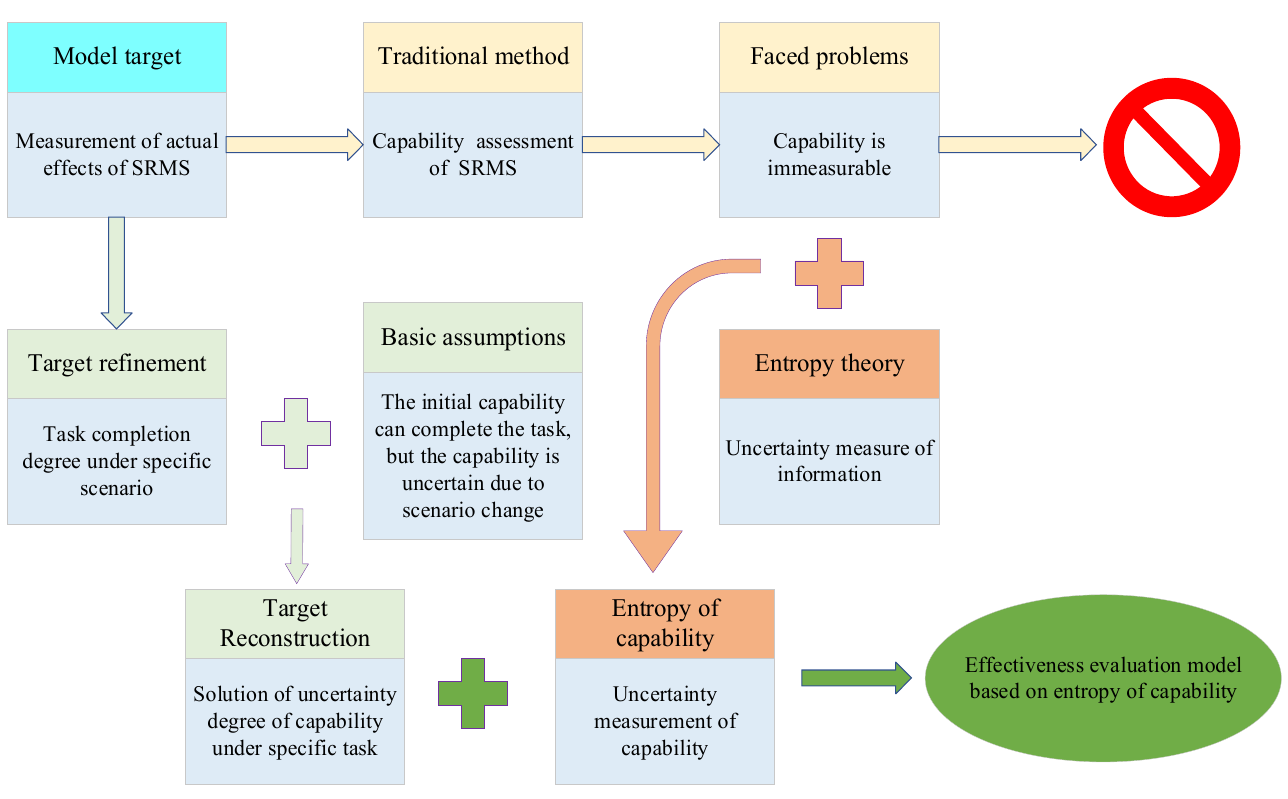
Figure 10. Derivation logic of effectiveness measurement based on entropy of capability.